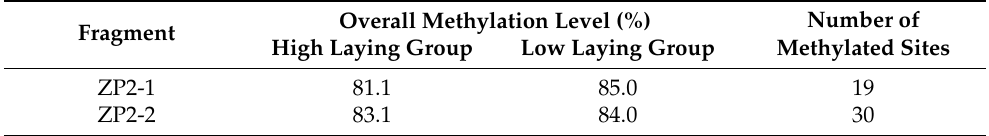
Table 5. The methylation level of amplified